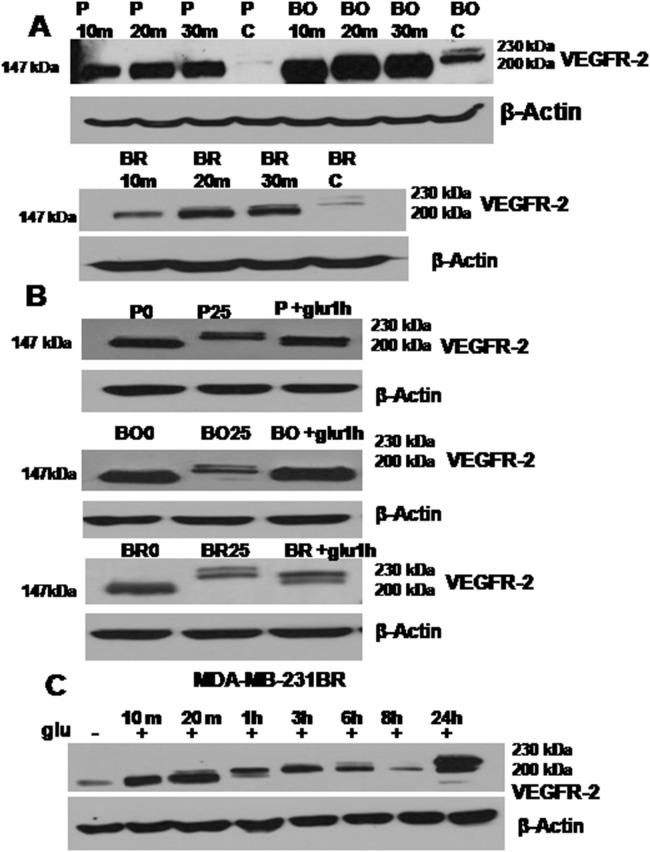
Glucose restoration resulted in a rapid glycosylation of the immature VEGFR2 band.(A) Western blot shows the VEGFR2 expression pattern in the cells exposed to 0 mM glucose media for a period of 24 hrs, followed by glucose restoration for 10, 20, 30 mins and the control cells (cells grown in control regular DMEM (25 mM glucose) without prior hypoglycemic exposure) P: MDA-MB-231P; BO: MDA-MB-231BO and BR: MDA-MB-231BR. The mature VEGFR2 band at 200 kDa was detected after 20 mins of glucose restoration which was more obvious in the MDA-MB-231BR (bottom blot). (B) Western blots showing that glucose restoration for 1 hour (after a period of 24 hrs of hypoglycemia) enhanced the formation of the glycosylated band of VEGFR2 (200 kDa) in all three cell lines MDA-MB-231P (P+glu 1hr), MDA-MB-231BO (BO+glu1h) and MDA-MB-231BR (BR+glu1h). The samples indicated by P25, B25 and BR25 are the samples collected from the cells growing in regular DMEM (25 mM glucose) expressing both mature bands of VEGFR2 (200 kDa and 230 kDa). P0, BO0 and BR0 are the MDA-MB-231P, MDA-MB-231BO and MDA-MB-231BR cells respectively, exposed to hypoglycemia for 24 hrs without glucose restoration. All three cell lines expressed only the unglycosylated band of VEGFR2 (147 kDa) when grown in 0 mM DMEM. (C) Western blots depicting the gradual increase in VEGFR2 band size upon glucose restoration in MDA-MB-231BR cells. Note: β-Actin was used in all the blots as a protein loading control.